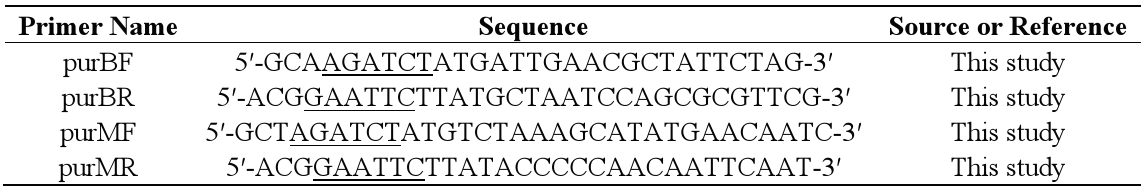
Table 1. Primers used in this study. The underlined sequences AGATCT and GAATTC represent the BglII and EcoRI restriction sites incorporated for cloning the wildtype gene into shuttle vector pRAB11 for complementation.